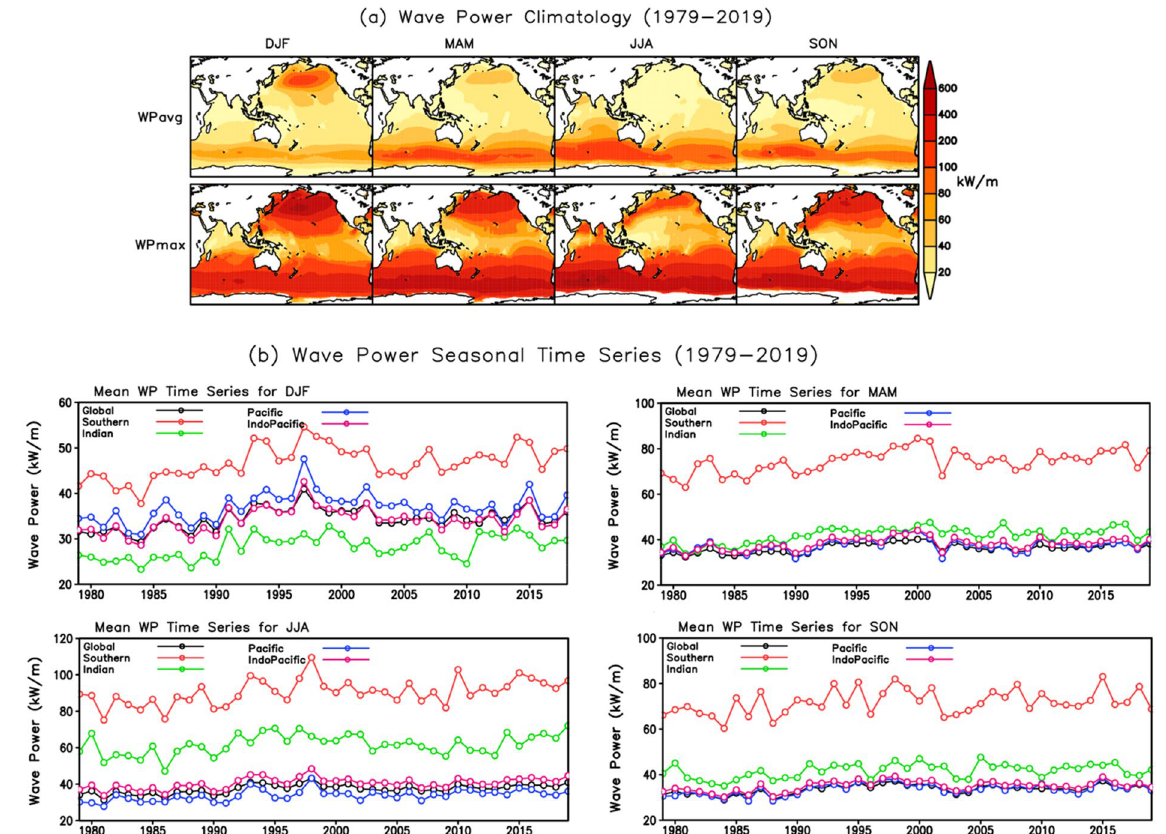
Figure 1. ( a ) Climatology patterns of the seasonal mean and extreme WP in the Indo-Pacific Ocean for the period 1979–2019. The unit of WP is kilowatts per meter (kW/m). ( b ) Seasonal mean WP time series for DJF, MAM, JJA, and SON, averaged over the global, Southern(80° S–40° S, 0° E–360°), Indian (90° S–30° N, 20° E–120° E), Pacific (90° S–90° N, 120° E–70° W), and Indo-Pacific (90° S–90° N, 20° E–70° W)